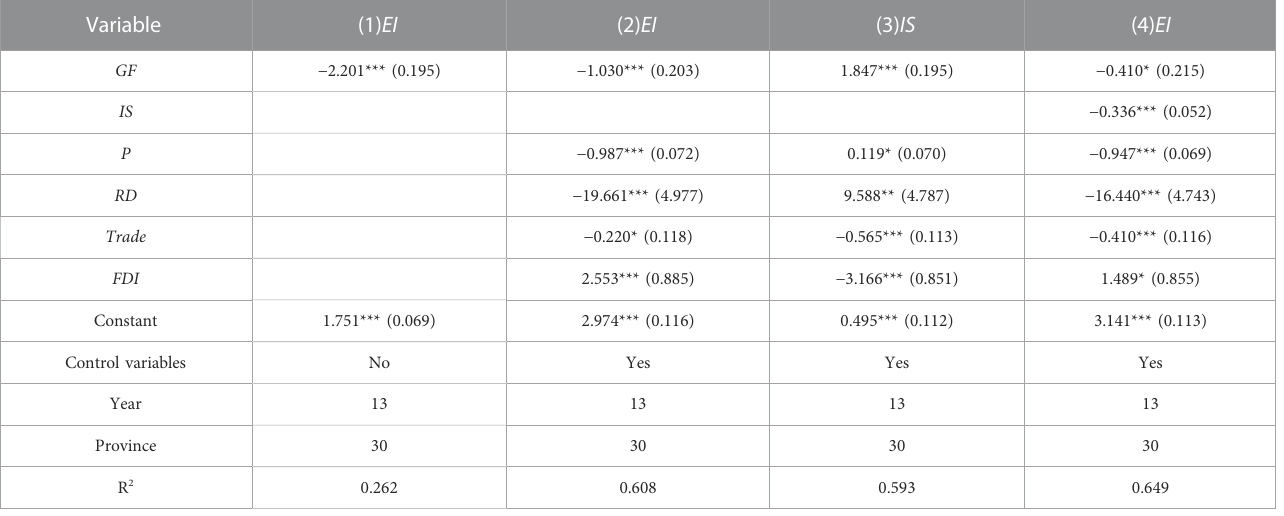
TABLE 2 Results of baseline regression and mechanism of action tests for the impact of green fi nance on energy intensity. Variable